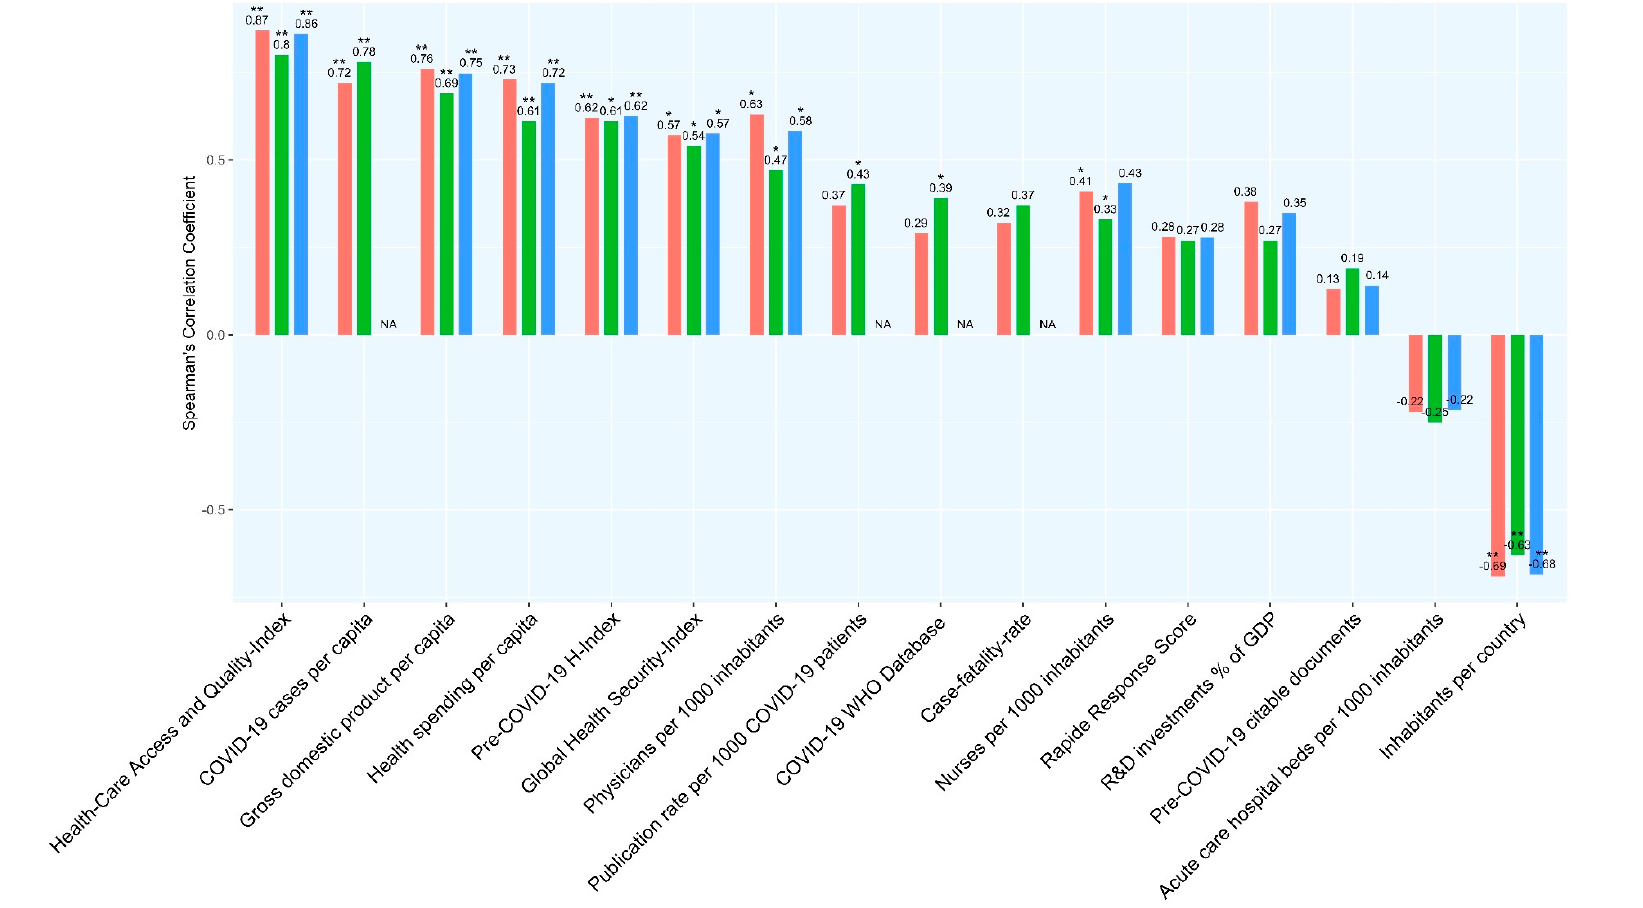
Figure 1. Correlations between COVID-19 publication rates and factors analysed. * p -value < 0.05, ** p -value < 0.0001